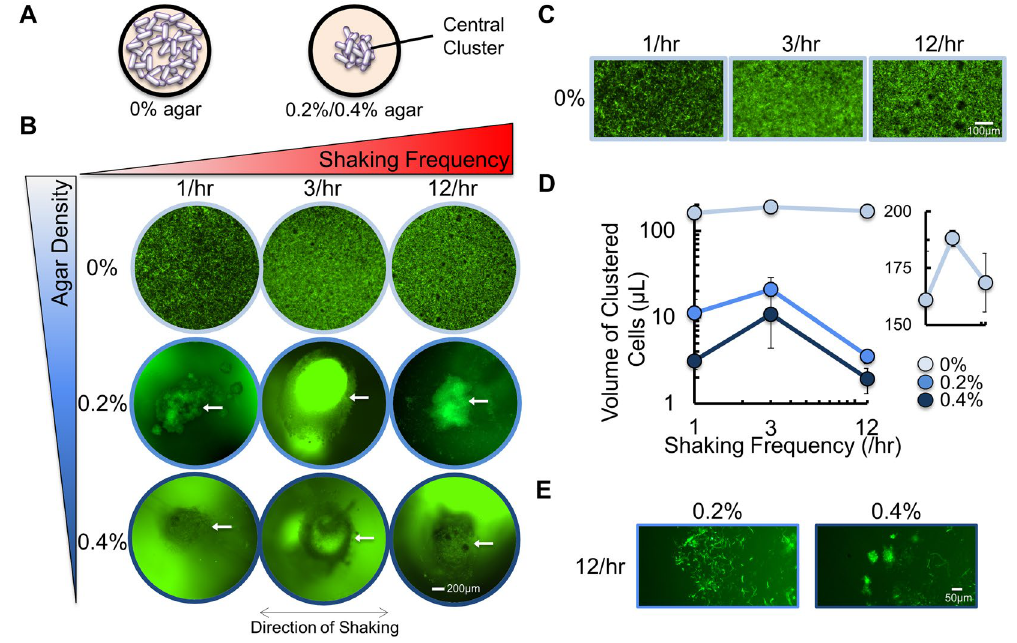
Figure 3. Periodic shaking of gfp -expressing bacteria in a microplate reader alters their spatial distribution. ( A ) When gfp -expressing bacteria were grown in medium with 0% agar, bacteria were spread amongst the well. When bacteria were grown in medium with 0.2% or 0.4% agar, the majority of bacteria were confined to a central cluster at the initial point of inoculation. ( B ) Representative images of gfp -expressing bacteria during periodic shaking of the microplate. The central cluster is indicated with a white arrow. For panels B, C and E, images taken at 24 hours. ( C ) Representative images of bacteria in 0% agar with increased magnification. ( D ) The volume of clustered gfp -expressing bacteria. In all agar densities, the volume of bacteria was highest at an intermediate shaking frequency (3/hr). Inset: Data expanded to show trend in medium with 0% agar. p < 0.048 when 1/hr and 12/hr are compared to 3/hr demonstrating significance in biphasic trend (one-tailed t-test). Volume calculated as described in Methods. SD from a minimum of three biological replicates. ( E ) Representative images of bacteria outside of the central cluster. Bacteria were scattered, less numerous and formed smaller